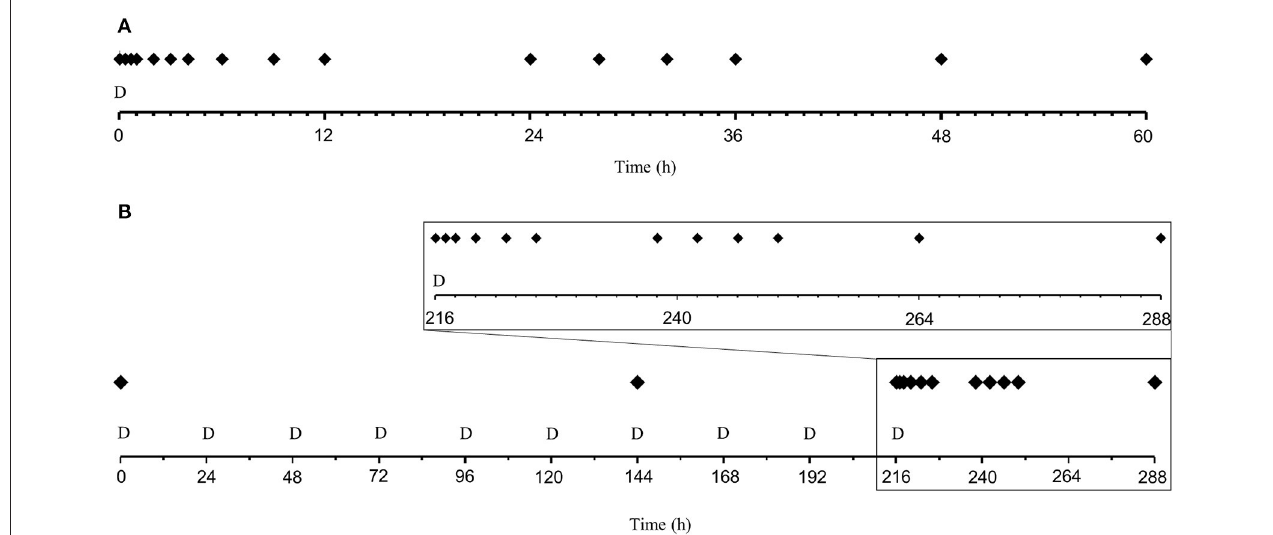
FIGURE 1 | Schematic overview of the dose (D) and sampling (filled diamonds) regimen after administration of 1 mg/kg prednisolone succinate and placebo intravenously (IV, upper plot “ A ”) or ∼ 1 mg/kg prednisolone or placebo once daily per os (PO, lower plot “ B ”) for 10 days to nine beagle dogs in a cross-over study. The magnification in the center show the 3 days following the last oral dose. (A) Dose and sampling regimen for IV administration. (B) Dose and sampling regimen for PO administration.